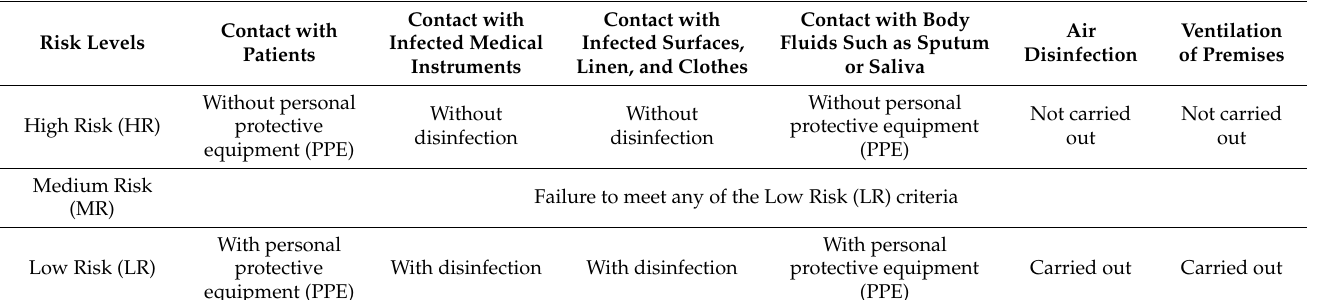
Table 2. Sechenov University Occupational Classification System (Based on COVID-19 Infectious